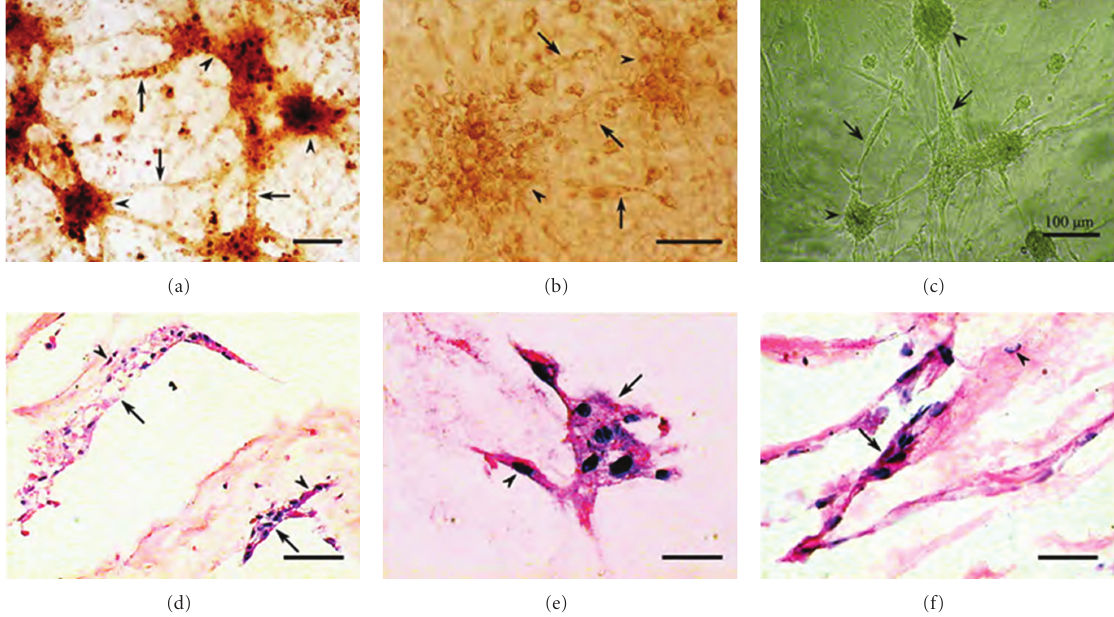
Figure 4: ((a)–(c)) Cell colony formation on the AHAM for di ff erent cell types. (a) Bovine bone marrow stromal cells, (b) NIH 3T3 cells, and (c) HFFs were observed to form colonies as star-shaped cell clusters. Arrowheads indicate cell clusters, and arrows indicate extensions from the cell clusters. Scale bar, 100 μ m. ((d)–(f)) Cells were observed to invade into the AHAM, as indicated by HE staining after 14 days of culture. (d) Bovine bone marrow stromal cells, (e) NIH 3T3 cells, and (f) HFFs. Arrows indicate cell clusters, and arrowheads indicate cells that are nearly penetrating the AHAM. Scale bar, 25 μ